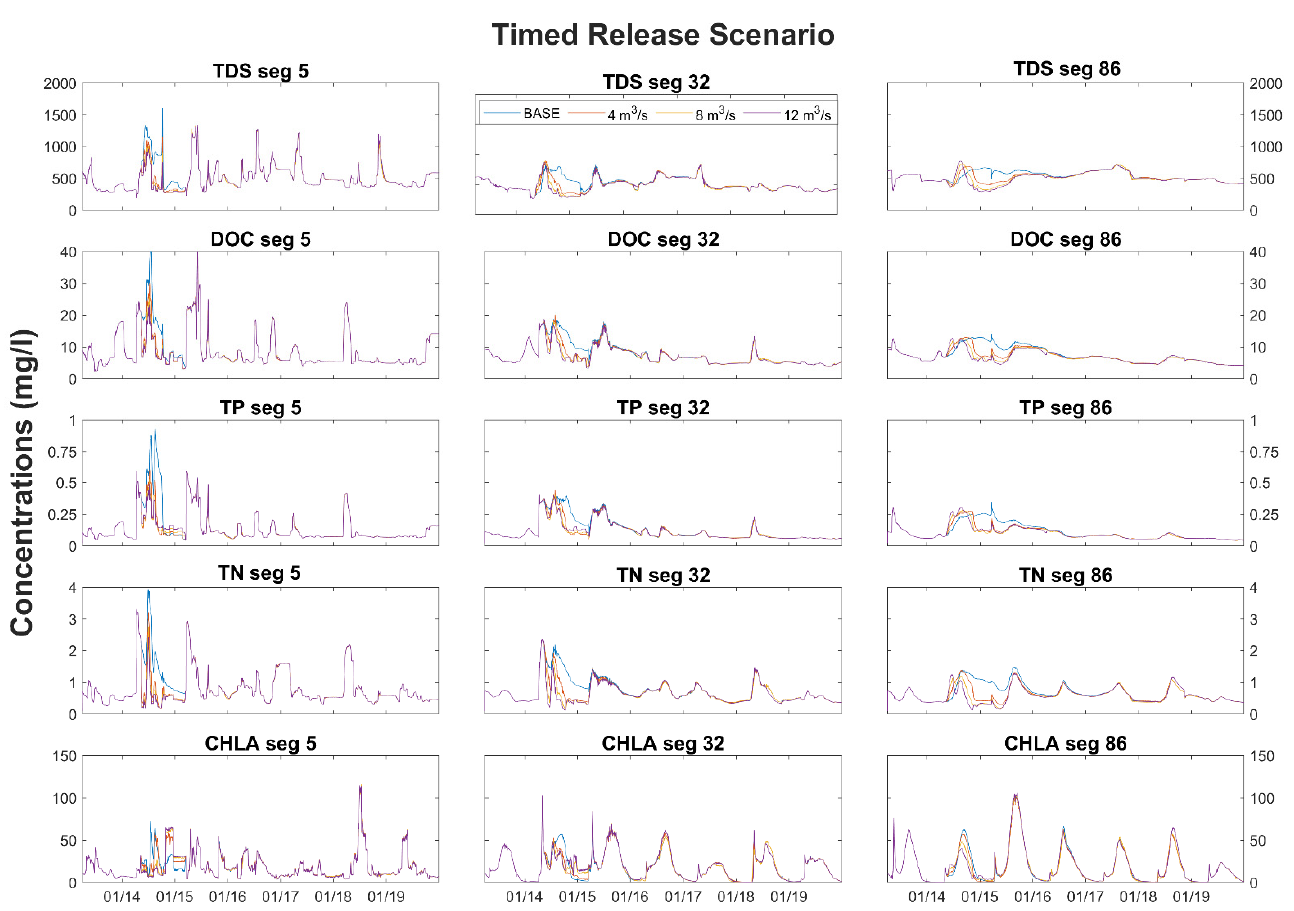
Figure 7. Output for five model-derived water quality constituents of interest at segments 5, 32 and 86 for the timed release 86 for the timed release scenario.